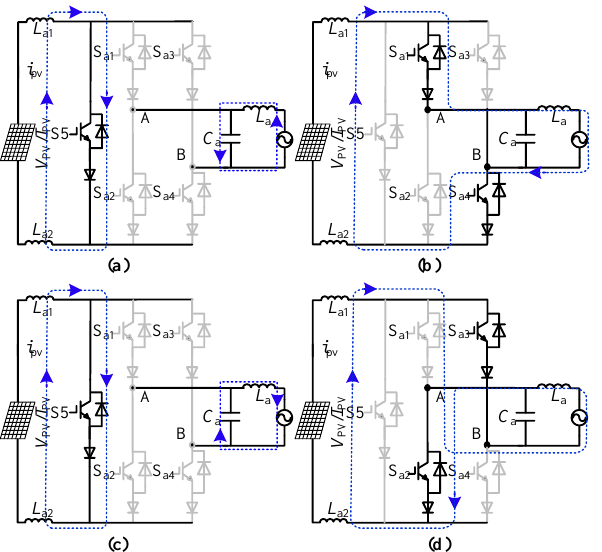
Figure 3. CH5 operating mode: ( a , c ) Sa5 ON is mode 0; ( b ) Sa1 & Sa4 ON is mode 1; ( d ) Sa2 & Sa3 ON is mode − 1. A and B are two connection points.